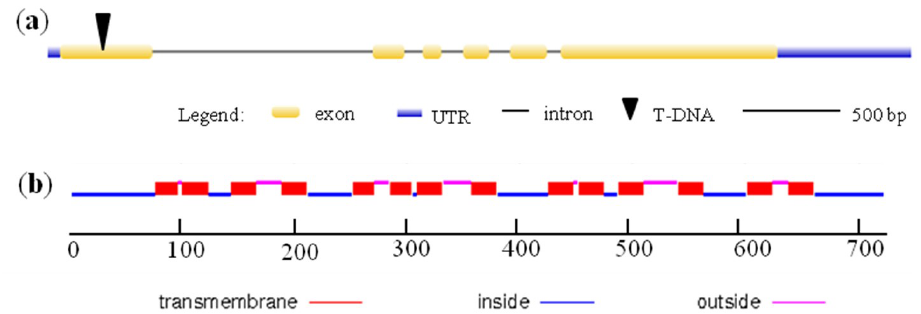
Figure 1. Sequence analysis of rice yellow stripe-like 13 ( OsYSL13 ) in rice. ( a ) The gene structure of OsYSL13 . The cDNA of OsYSL13 was cloned from the cDNA library of Oryza sativa cv. Nipponbare and its sequence were consistent with the sequence published in the GenBank/EMBL databases (accession number Os04g0524500). Exon, intron, and 5′ and 3′ untranslated region (UTR) were shown. The T-DNA was inserted into the first exon. ( b ) Predicted transmembrane domains of OsYSL13 by TMHMM2.0. There were 14 transmembrane domains in OsYSL13 .